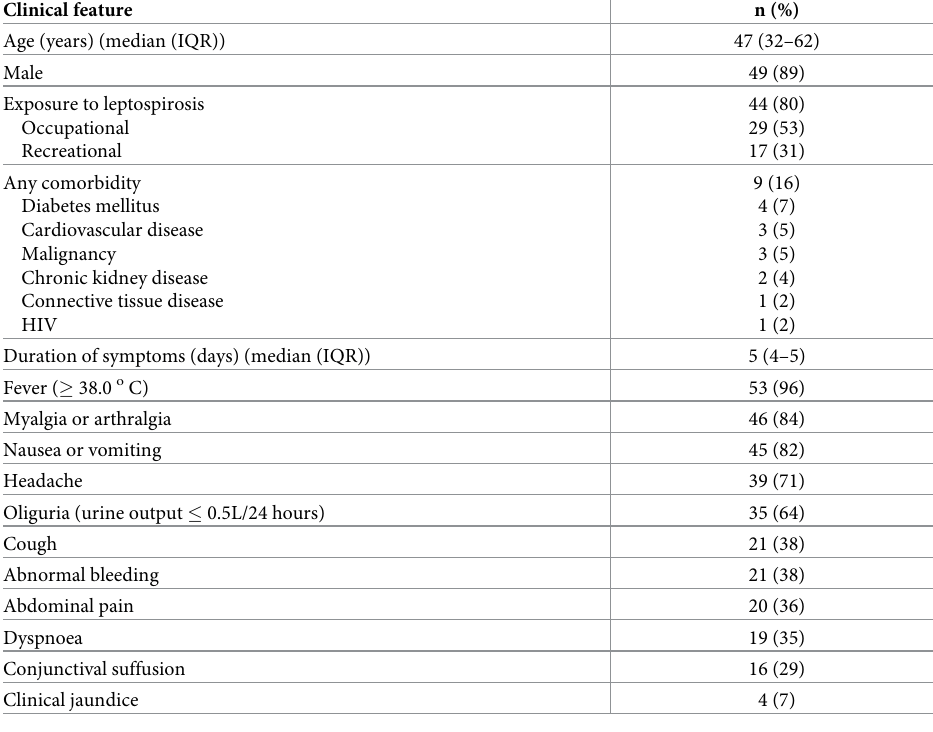
Table 1. Baseline characteristics of patients at time of presentation to hospital who subsequently required inten- sive care unit support for severe leptospirosis in Far North Queensland, Australia between 1997 and 2018. Clinical